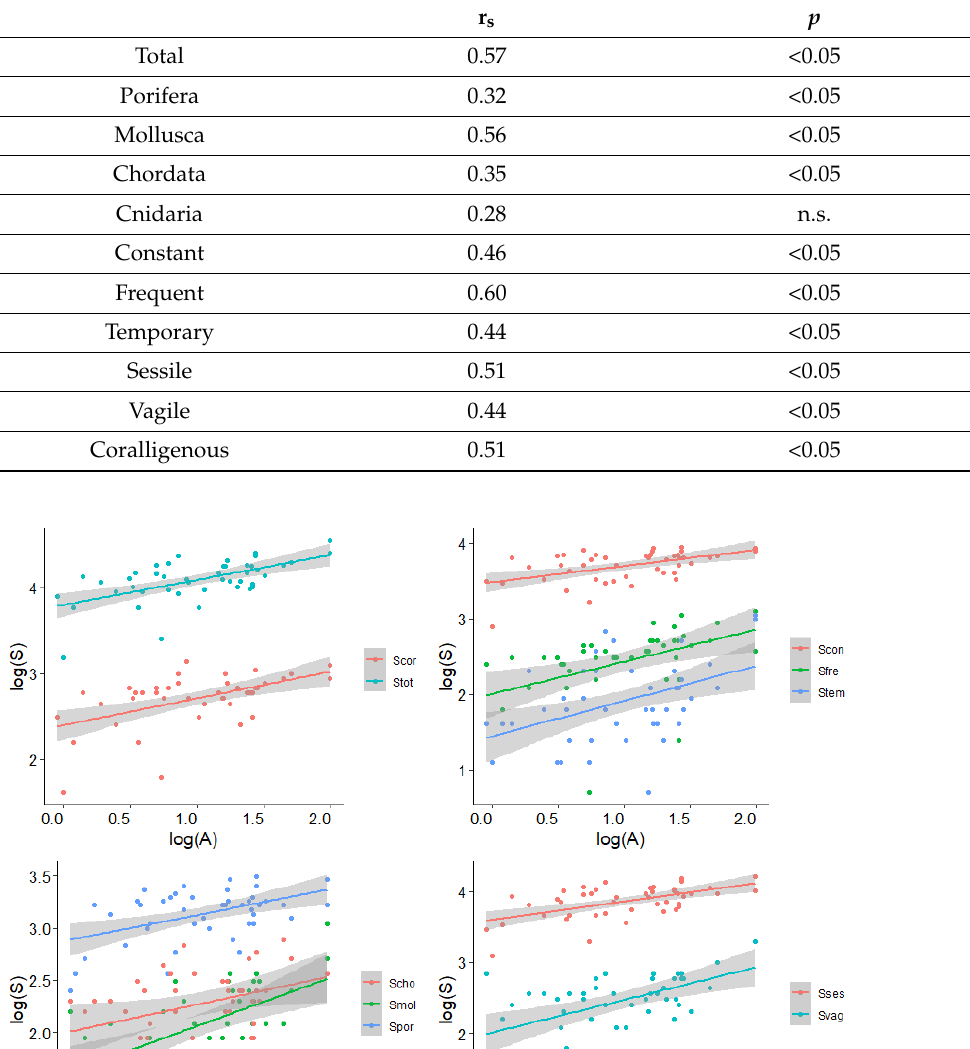
Table 3. Results of Spearman correlation between sample size and taxa richness: correlation coefficient (r s ) and its significance ( p ). n.s. = non-significant.